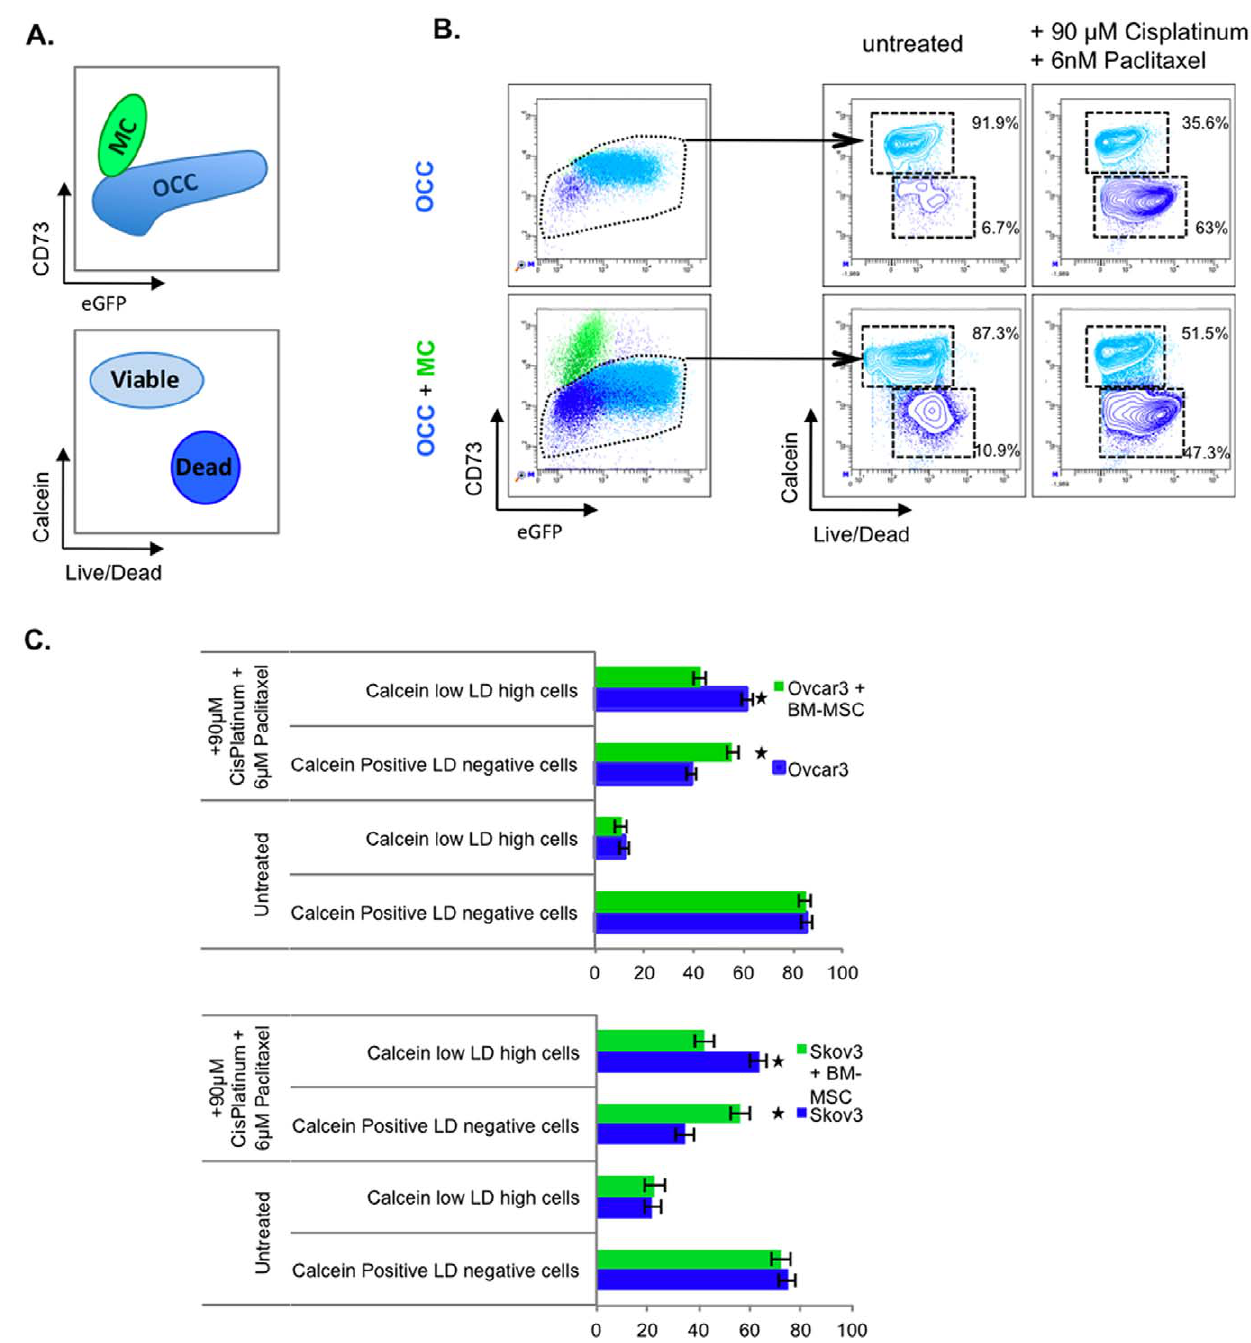
Figure 4. MC protects OCC from chemotherapy induced cell death. A. Explanative scheme of FACS analysis. B . OCC or OCC co-cultivated with MSC were treated for 48 hours with 90 m M of Cisplatin and 6 nm of Paclitaxel. Cell types were discriminated by FACS using GFP as a cancer cell marker, and CD73 as an MC marker. Cell death analysis was carried out using the dual Calcein/Live Dead staining. C . Quantitation of cell death analysis experiments. OCC display a resistance to conventional chemotherapy treatment when co-cultivated with MC compared to the control. SEM are represented, n=3, | p , 0.05 t-Student Test.